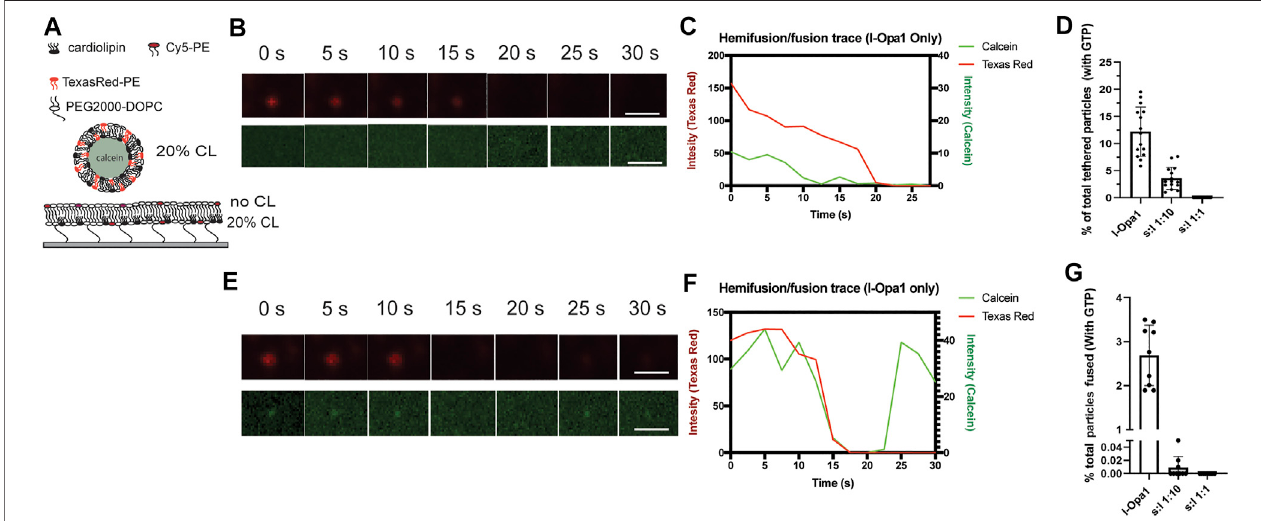
FIGURE 4| CL distribution determines the ef fi ciency and kinetics ofl-Opa1 mediated membrane lipid demixing (hemifusion) and content release. (A) Schematic of the experiment showing asymmetric cardiolipin distribution in the membrane, both bilayers with l-Opa1 reconstituted. The lipid bilayer top lea fl et was CL free, while the bottom lea fl et contained 20% (mol) CL. (B) Example of hemifusion event without calcein release. The total process takes ∼ 20 s. Full fusion kinetics shown in (E) , with calceinrelease observed after 30 softotal recordingtime.Thetotal number ofparticlesanalyzed from 3to5bilayersquanti fi ed in (D) (hemifusion) and (G) (fullpore opening), under the asymmetric cardiolipin distribution conditions illustrated in A. Data were collected from three different experiments. Scale bar in images, 1